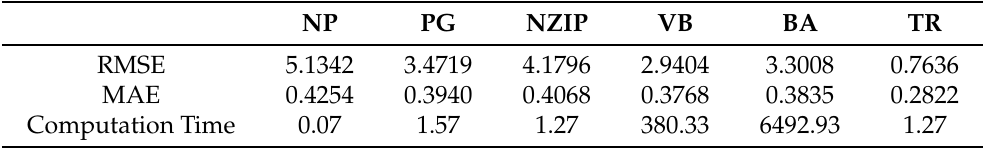
Table 1. Out-of-sample validation with simulated